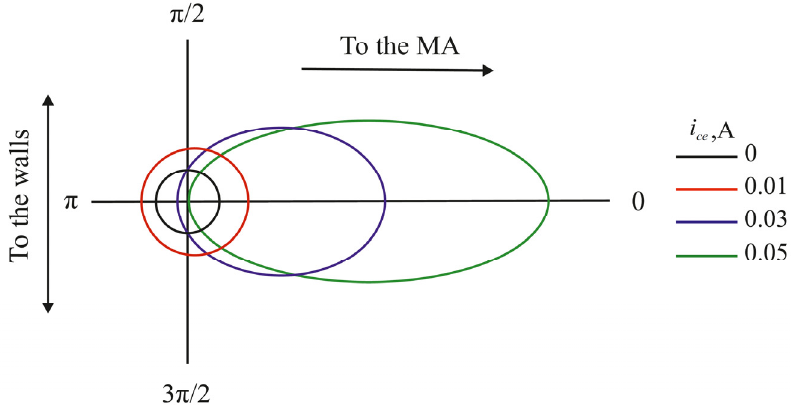
Figure 9. Angular structure of the thermal electrons’ EVDF near the anode hole for various currents at the CE and P He = 3 Torr. The horizontal axis coincides with the discharge symmetry axis.